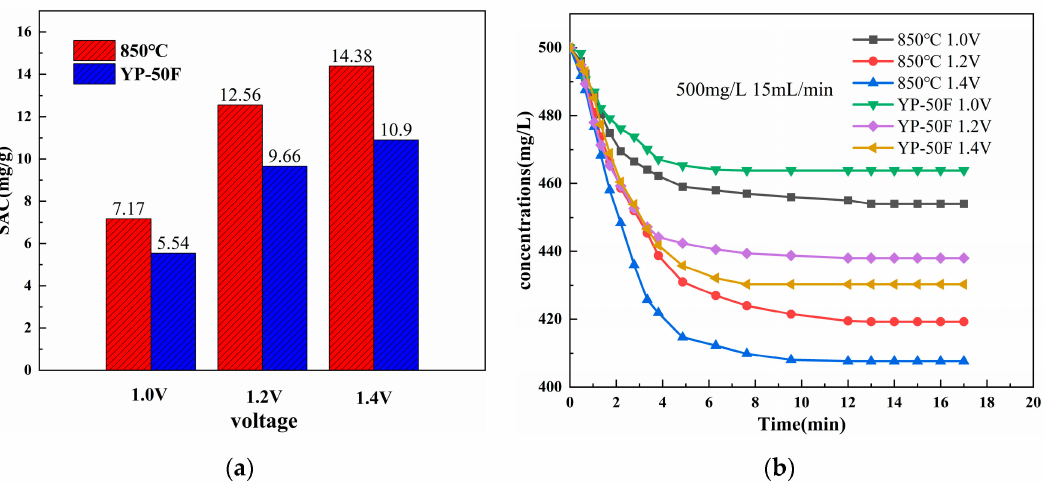
Figure 14. ( a ) SAC of YP-50F and N-doped layered porous carbon at 850 ◦ C pyrolysis temperature. ( b ) Concentration-time curves of N-doped layered porous carbon at YP-50F and 850 ◦ C pyrolysis temperature under different voltage